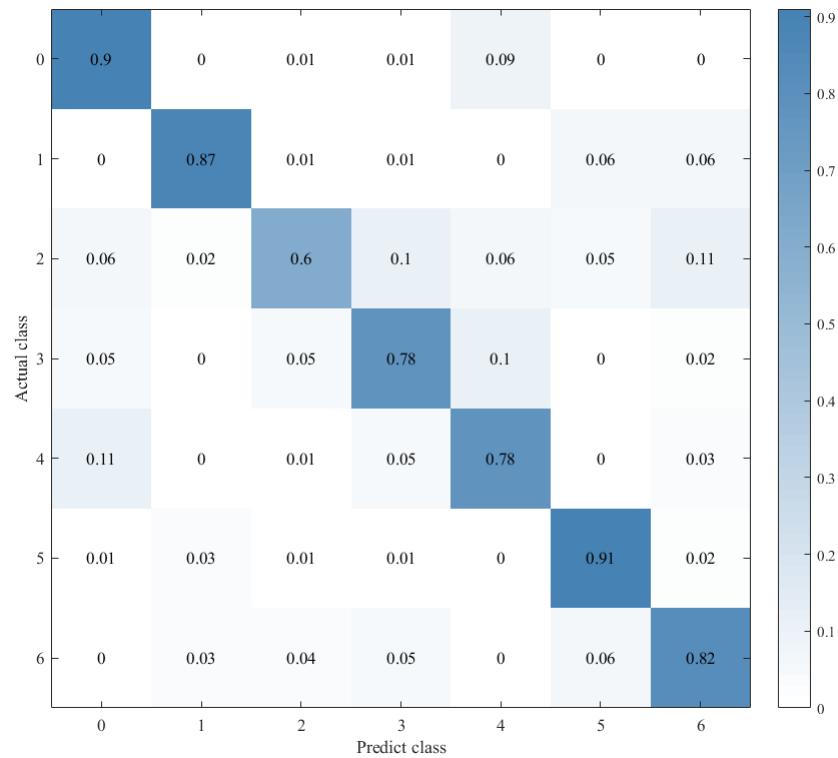
Figure 12. Confusion matrix for CNN+LSTM×2+Global-Attention.